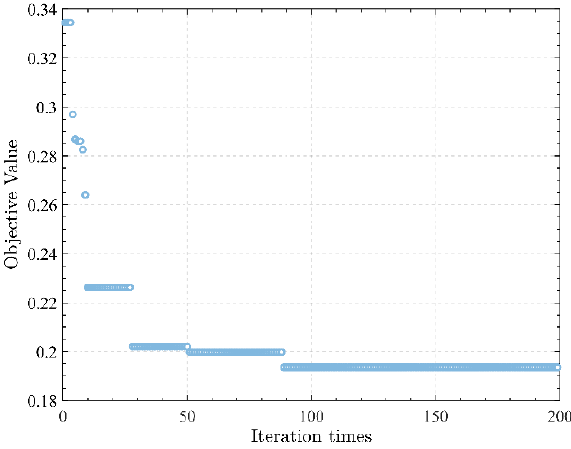
Figure 7. Optimal trace of every generation.